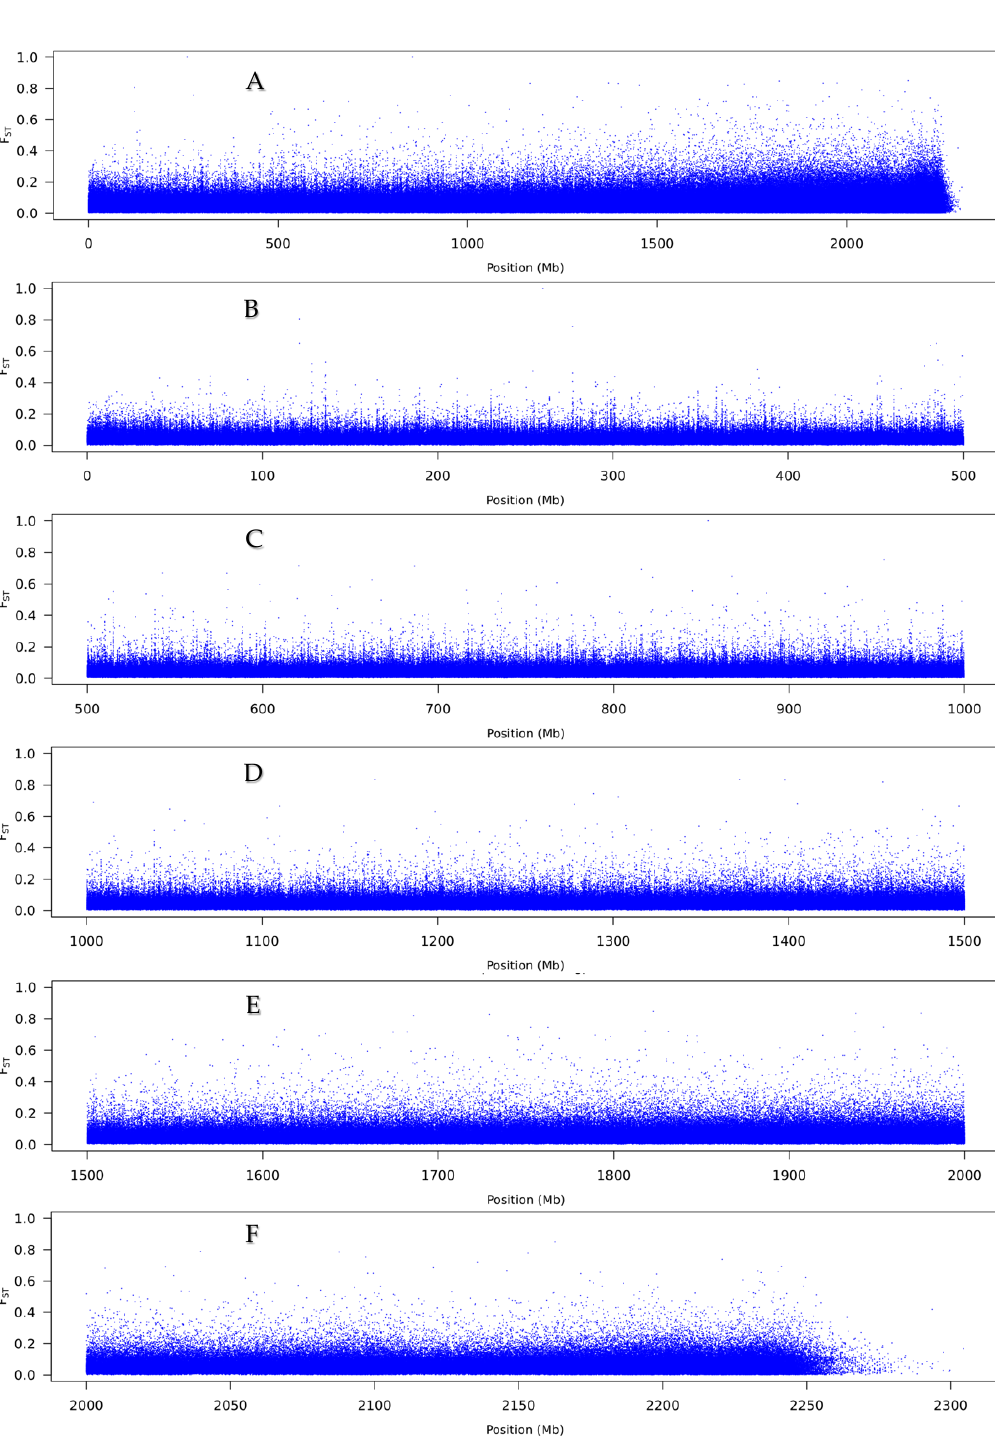
Figure 8. F ST summary from the comparison of the pools of anaflexistylous and cataflexistylous individuals of Alpinia nigra , for window size of 1 kbp and step size of 1 kbp. ( A ) Genome-wide F ST scan, ( B ) scan across the first 500 Mbp, ( C ) scan from 500 to 1000 Mbp, ( D ) scan from 1000 to 1500 Mbp, ( E ) scan from 1500 to 2000 Mbp and ( F ) scan from 2000 Mbp to end. The scaffolds are ordered by length starting from the largest.